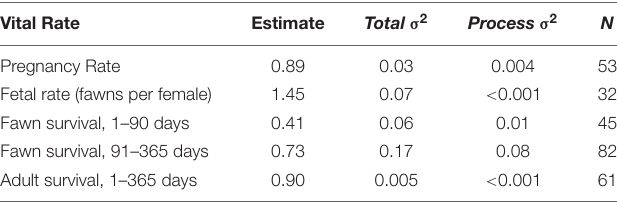
TABLE 2 | Estimates of vital rates for across the period of the study (2010–2013) for Sitka black-tailed deer, Prince of Wales Island, AK, United States. Vital